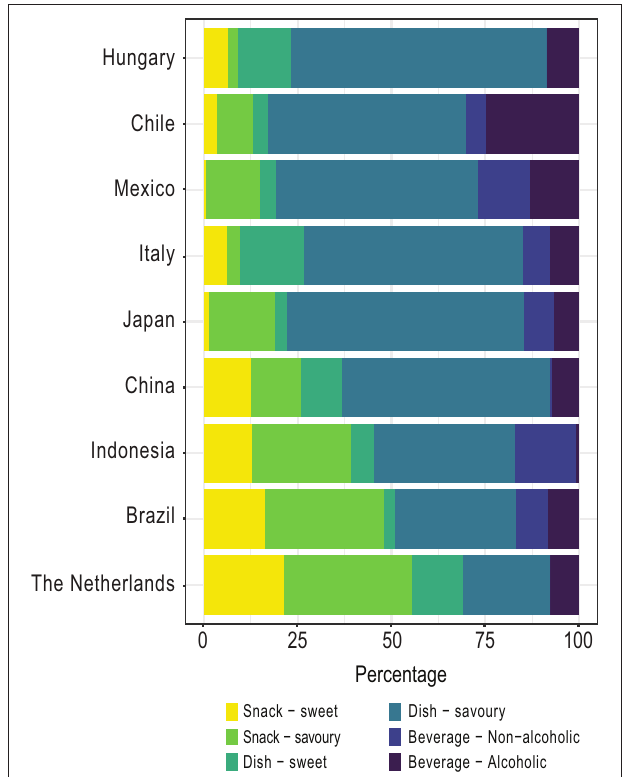
FIGURE 4 | Consumption moment of traditional foods/beverages by country. Percentage of consumption moment situations of TFBs relative to the number of traditional foods/beverages most frequently mentioned by country (stated by ≥ 13% of